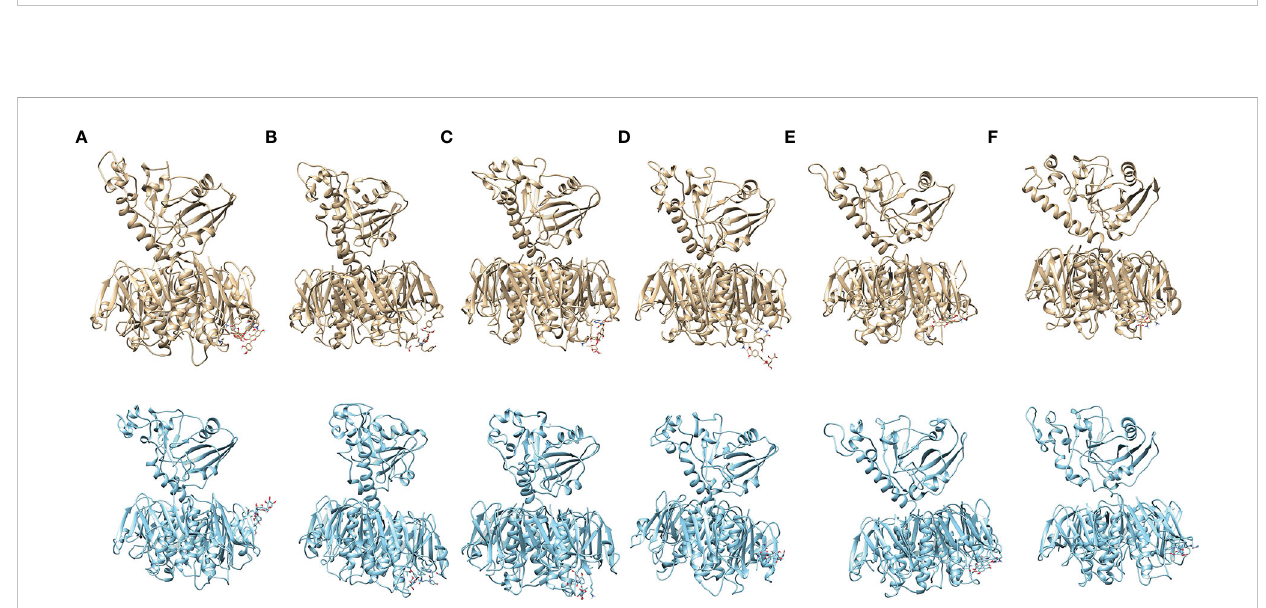
FIGURE 6 The MD simulation snapshots revealing the stable complex formation during the 100ns of simulation. The starting MD conformations are shown in gold (A1-F1) while MD simulation end structure (100ns) are shown in cyan (A2-F2), where (A – F) represents complexes CT-RTN, CT-PHD, CT-QRTN, CT-CHL, CT-EA and CT-GA